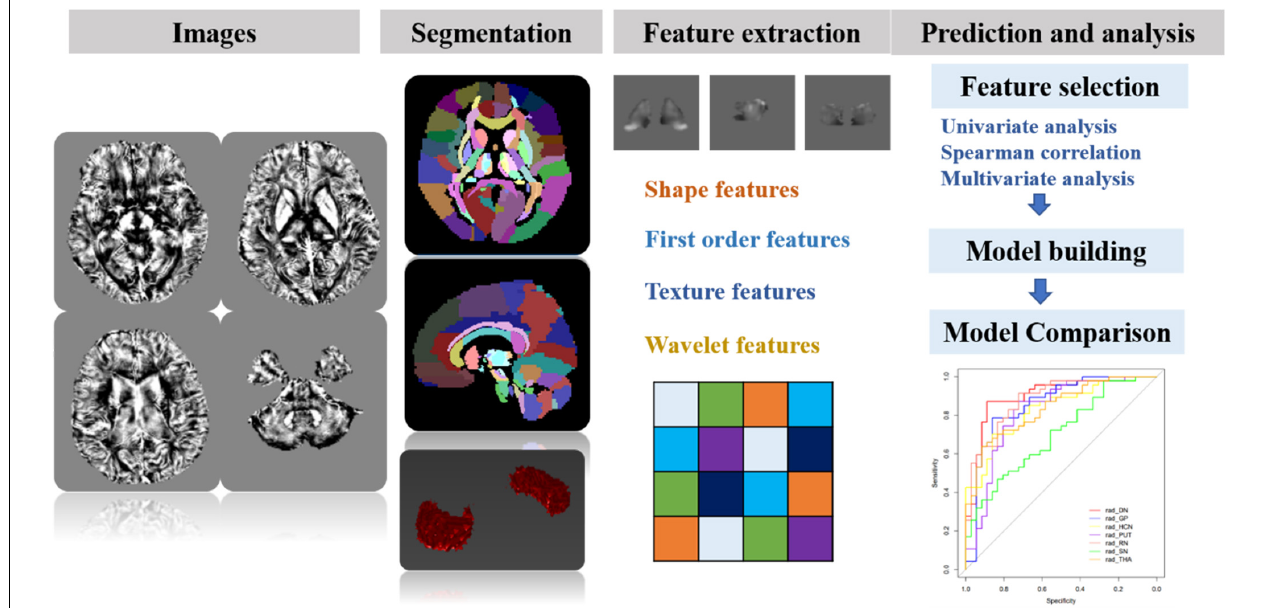
FIGURE 3 | The schematic flowchart of processing steps. Step 1: QSM reconstructions were performed. Step 2: after QSM atlas registration, seven ROIs were segmented on QSM images. Step 3: four sets of most representative features were chosen for generalizing and optimizing the model. Step 4: after feature selection, the prediction model for differentiating MS and NMOSD was built by combining radiomic features and clinical information. Furthermore, the classification performance was assessed with AUC using fivefold cross-validation.